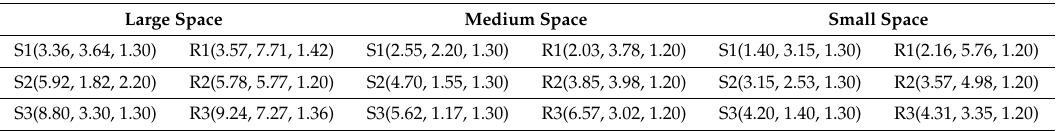
Table A2. Source and receiver positions for measurements at di ff erent spaces (i.e., large, medium, small) corresponding to Figure 2B–D,